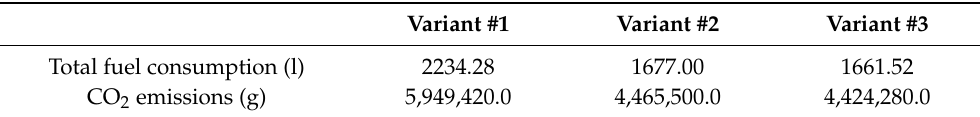
Table 17. Total fuel consumption and CO 2 emissions for each